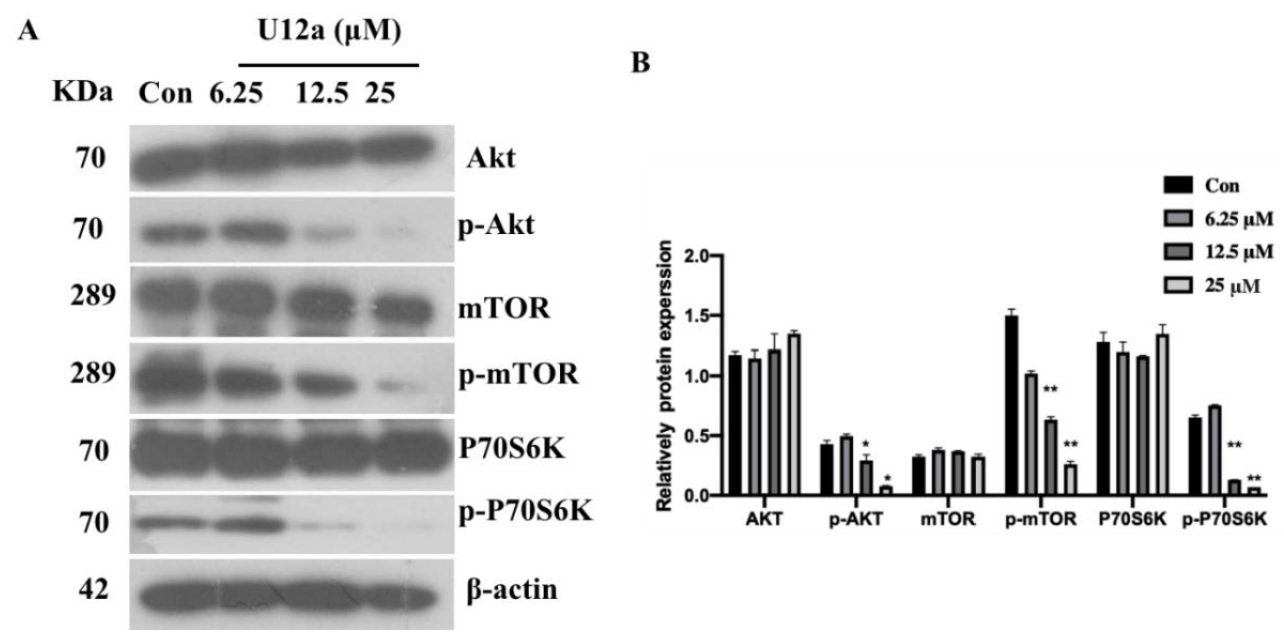
Figure 5. Effect of U12a on the PI3K/AKT/mTOR pathway in HepG2 cell. ( A ) Protein expression levels of AKT, p-AKT, mTOR, p-mTOR, p70S6k, p-p70S6k and β -actin in HepG2 cells with Ua12 (6.26, 12.5, 25 μM) for 24 h. ( B ) The bar graph describes the relative gray values of related proteins that were calculated using image J. All data represent the mean ± SD of three independent experiments. * p < 0.05, ** p < 0.01 compared with the Con group.